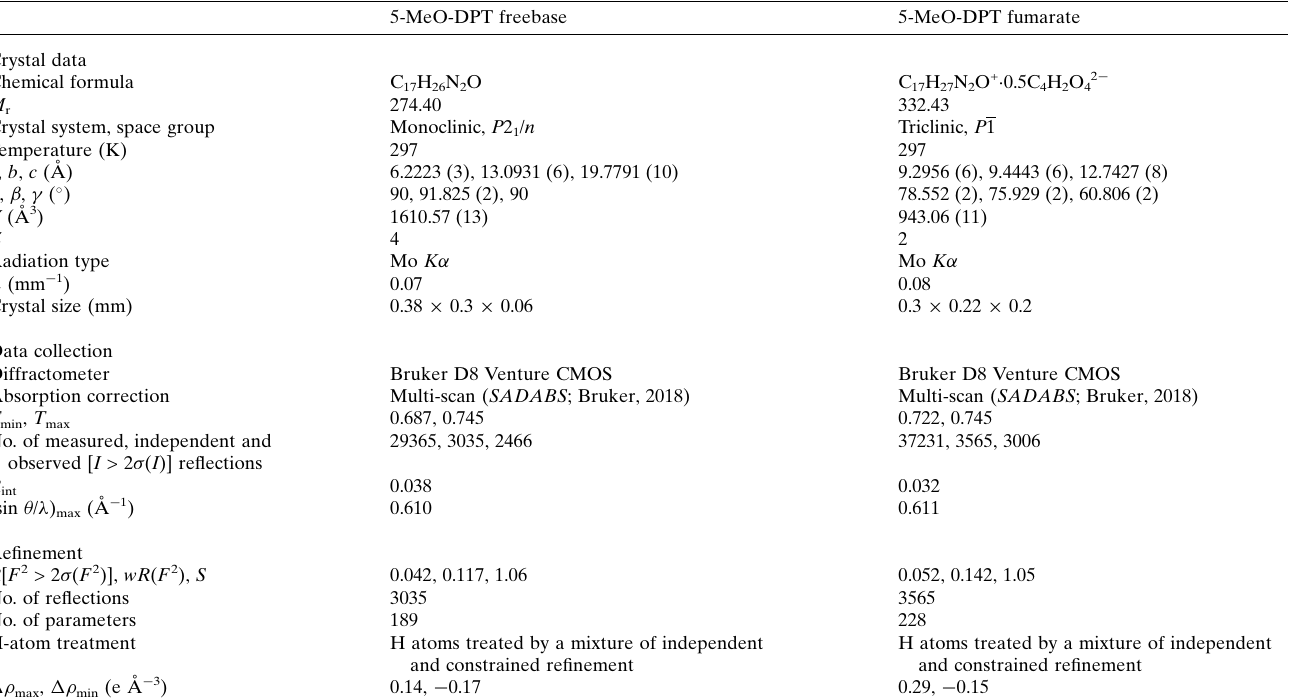
Figure 2 The crystal packing of 5-MeO-DPT freebase (left), viewed along the a axis, and the crystal packing of 5-MeO-DPT fumarate (right), viewed along the a axis. The hydrogen bonds (Tables 1 and 2) are shown as dashed lines. Hydrogen atoms not involved in hydrogen bonds are omitted for clarity. Table 3 Experimental